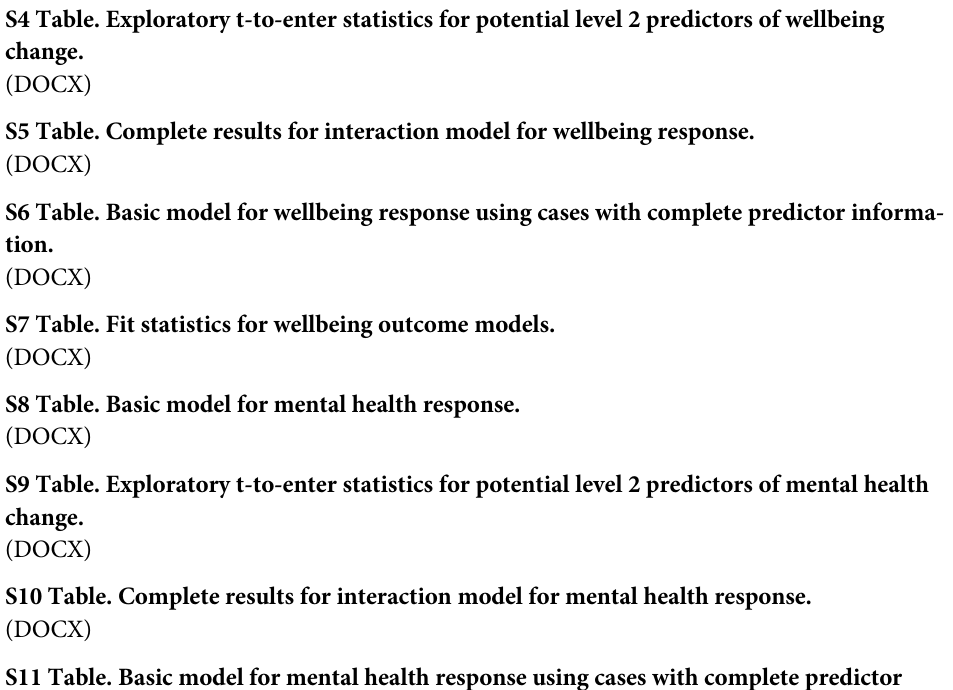
S3 Table. Basic model for wellbeing response. S4 Table. Exploratory t-to-enter statistics for potential level 2 predictors of wellbeing change. S5 Table. Complete results for interaction model for wellbeing response. S6 Table. Basic model for wellbeing response using cases with complete predictor informa- tion. S7 Table. Fit statistics for wellbeing outcome models. S8 Table. Basic model for mental health response. S9 Table. Exploratory t-to-enter statistics for potential level 2 predictors of mental health change. S10 Table. Complete results for interaction model for mental health response. S11 Table. Basic model for mental health response using cases with complete predictor information. S12 Table. Fit statistics for mental health outcome models. S13 Table. Complete results for interaction model for wellbeing response, not including effort measures as predictors. S14 Table. Complete results for interaction model for mental health response, not includ- ing effort measures as predictors. S1 Fig. Power curve of interaction effect of agreeableness during the intervention phase for wellbeing